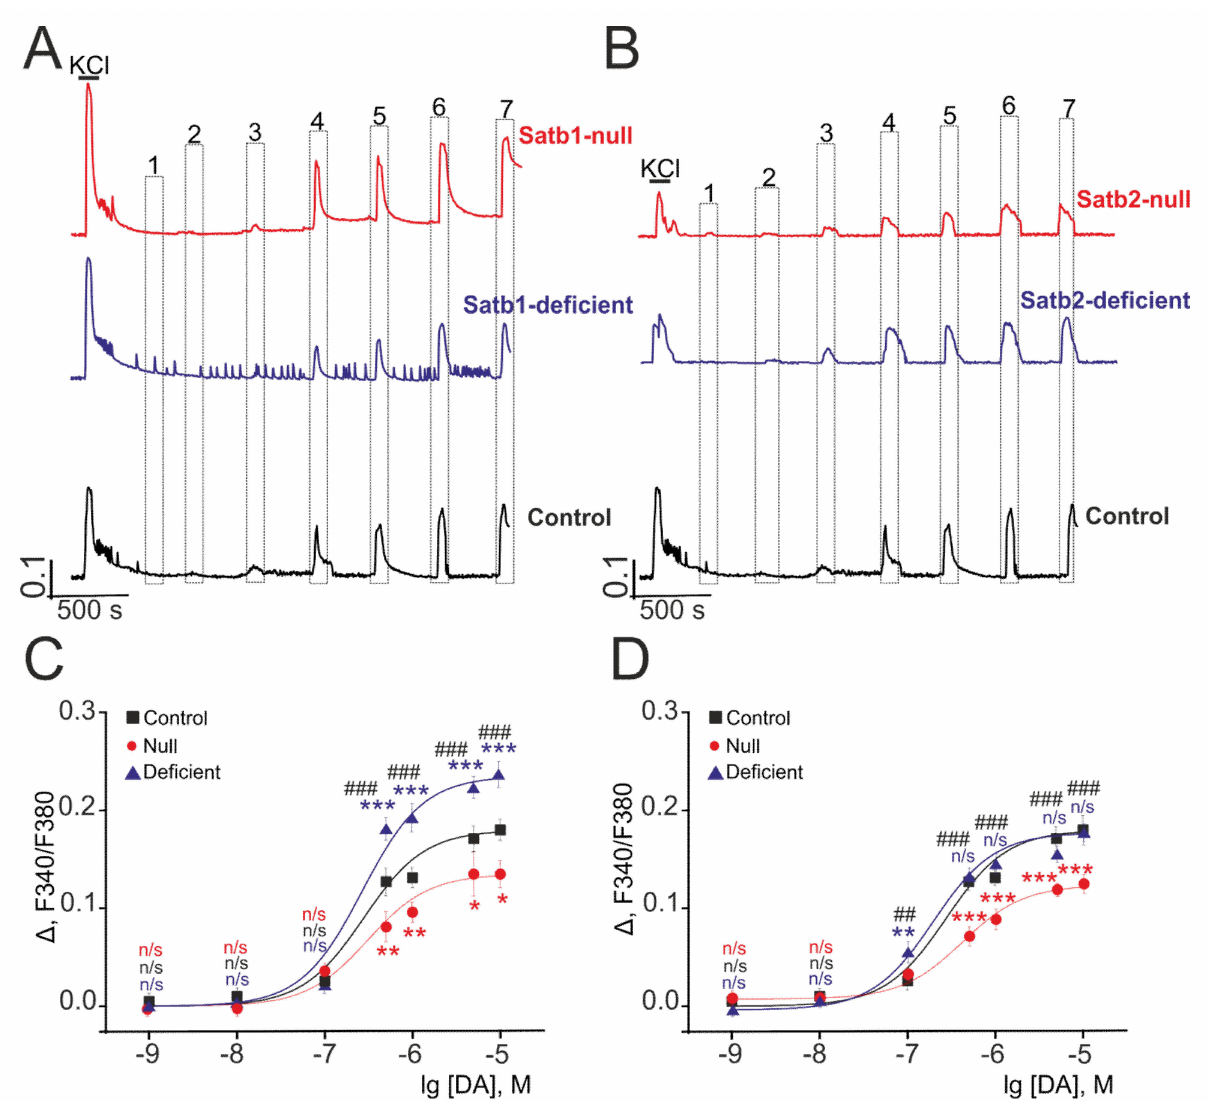
Figure 6. The effect of deletion in the transcription factors Satb1 and Satb2 on the Ca 2+ -signals produced by cortical neurons after activation of kainate receptors. ( A , B ) application of enhancing concentrations of KA-receptors activator, domoic acid (DA) in the presence of a selective antagonist of the AMPA-receptors, GYKI-52466 (30 µ M) and an inhibitor for desensitization of the KA-receptors, concanavalin A (ConA, 200 µ g/mL) to the neurons of brain cortex isolated from the Satb1 ( A ) and Satb2 ( B ) knockout mice. ( C , D ) dependence of the Ca 2+ -responses amplitude on DA concentration in the cultured cortical neurons from Satb1 ( C ) and Satb2 ( D ) knockout mice. DA concentrations are specified with horizontal lines accompanied with correspondent cyphers: 1–0.001, 2–0.01, 3–0.1, 4–0.5, 5–1, 6–5, 7–10 µ M. For each concentration, average data are represented, obtained from several hundreds of neurons in 5 independent experiments ± SEM. For panels ( A , B ), averaged Ca 2+ -responses for neurons from individual experiments are represented. For panels ( A , B ), we analyzed 200 cells ( n = 200) in each experiment. For panels ( C , D ), every experiment was repeated four times ( n = 4) using cell cultures from separate passages. Statistical analyses were performed by two-way ANOVA, followed by Sidak’s multiple comparison test. * p < 0.05, ** p < 0.01, and *** p < 0.001 comparing Satb-deficient group (blue asterisk) and Satb-null group (red asterisk) with control group; ## p < 0.01, and ### p < 0.001 comparing Satb-deficient group with Satb-null group; n/s (blue) and n/s (black)—data not significant in experimental Satb-deficient group compared to control group, and Satb-deficient group compared to Satb-null group,